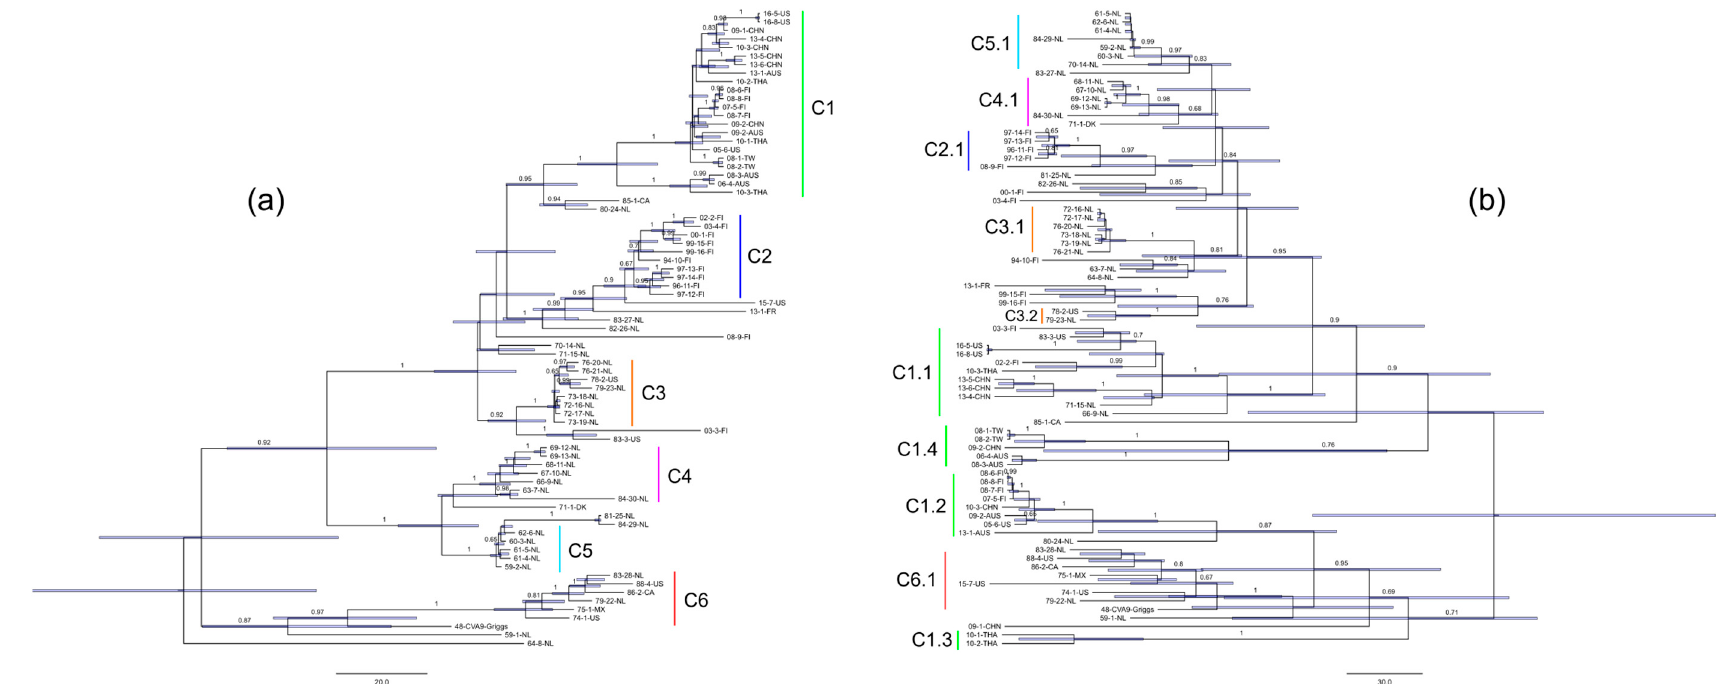
Figure 1. CVA9 phylogenies for ( a ) VP1 and ( b ) 3Dpol regions. Clades for VP1 region were manually assigned based on tree topology, and the 3Dpol region was set to reflect this grouping. Bootstrap values of ≥ 65% are shown. The light blue bars represent 95% HPDs for ancestor estimates. The scale bar represents time in years.